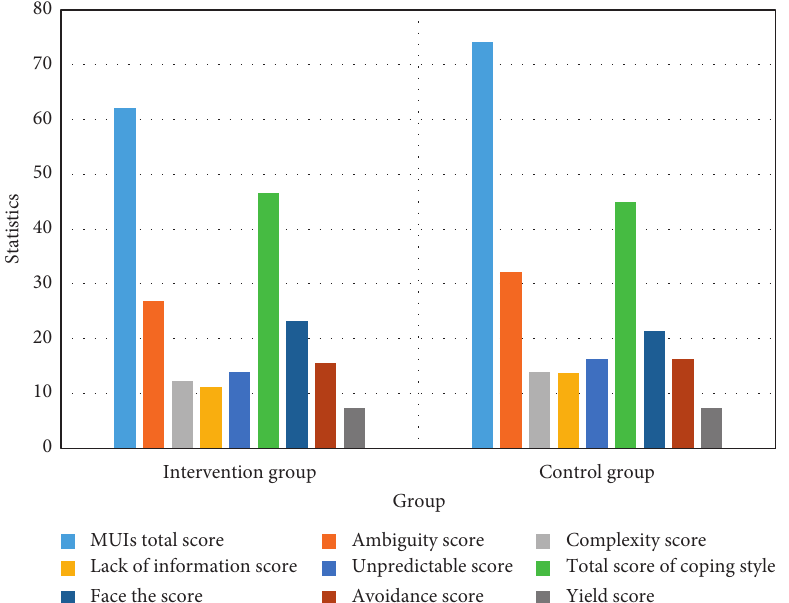
Figure 3: Comparison and analysis of uncertainty of disease and coping style between the two groups after